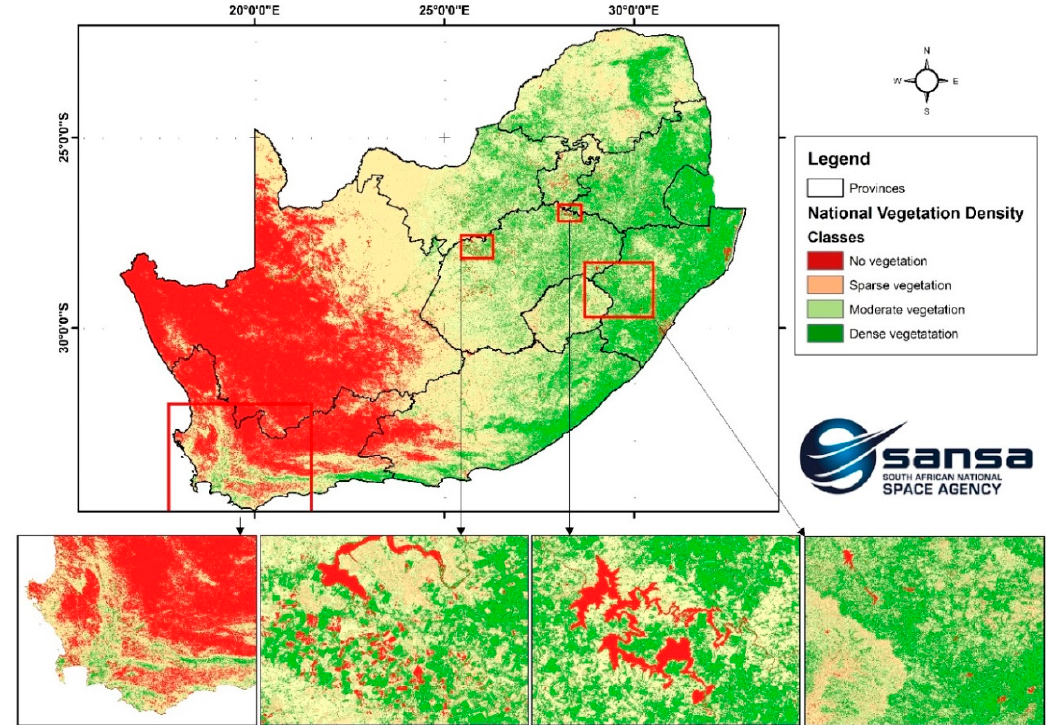
Figure 6. National vegetation density map showing vegetation status for 2018 wet season (Nov–Apr). Left : Western Cape’s drier conditions. Centre-left : Cropped and fallow areas. Centre-right : Vaal Dam water extent. Right : Mountain greenness in the Drakensberg Mountains.